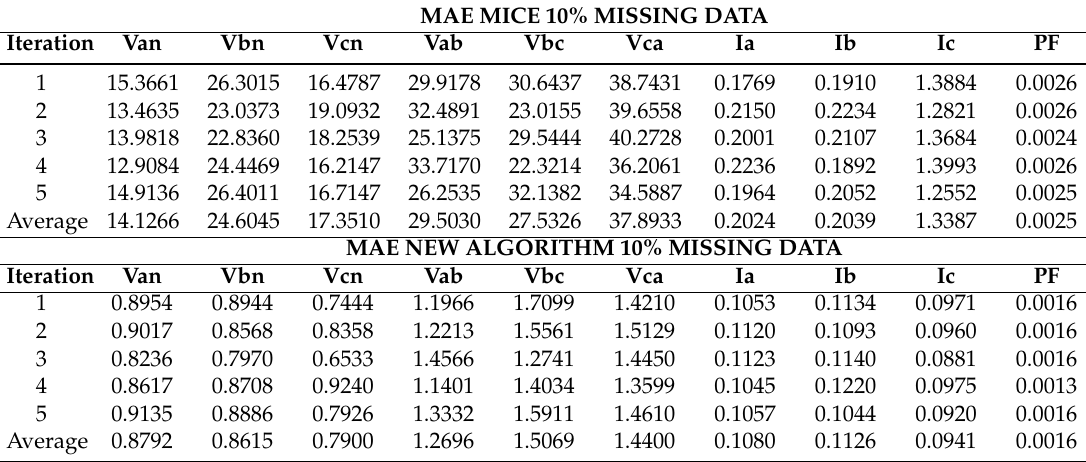
Table 7. MAE obtained with a 10% of missing data MICE and new proposed AAA